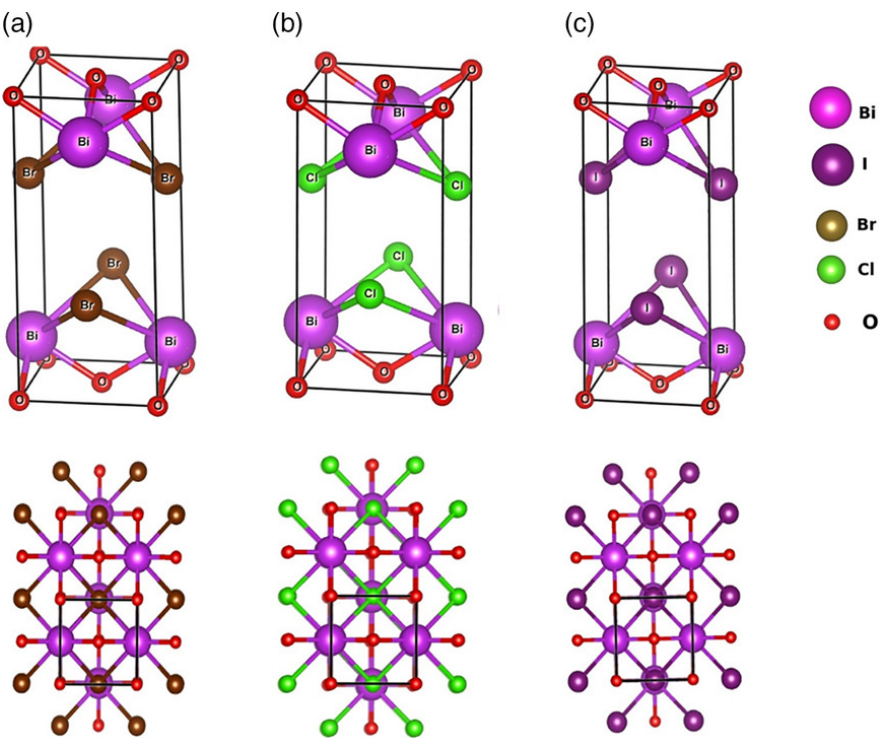
Figure 7. Crystal structure of ( a ) BiOBr, ( b ), BiOCl, and ( c ) BiOI photocatalysts. Reproduced with permission [104], Copyright 2020, Elsevier.